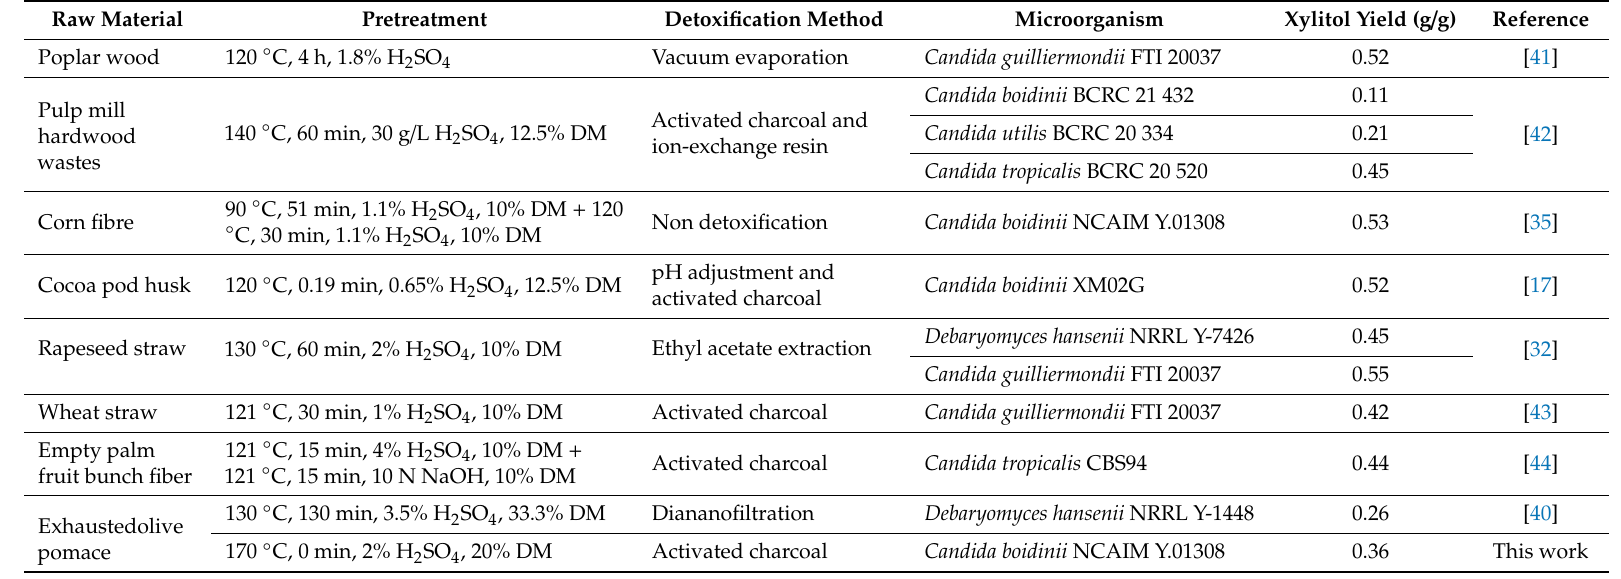
Table 3. Xylitol yields reported in the fermentation of hemicellulosic hydrolysates from diverse lignocellulosic. residues, using di ff erent types of